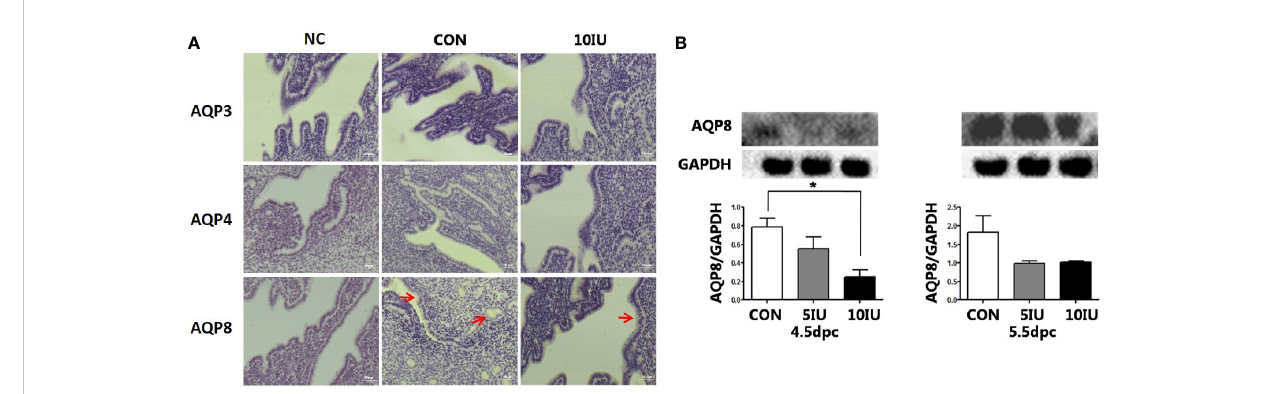
FIGURE 8 Localization and protein expression of the aquaporins AQP3, AQP4 and AQP8 in the mouse endometrium at 4.5 dpc and 5.5 dpc among the CON, 5 IU and 10 IU groups. (A) Localization of AQP3, AQP4 and AQP8 in the endometria of mice in the CON and 10 IU groups at 5.5 dpc. Bar=50 m m. (B) Protein expression of AQP8 in the endometria of mice in the CON, 5 IU and 10 IU groups at 4.5 dpc and 5.5 dpc. NC: negative control. Compared with the CON group, *p<0.05. The arrows indicate the localization of target protein.